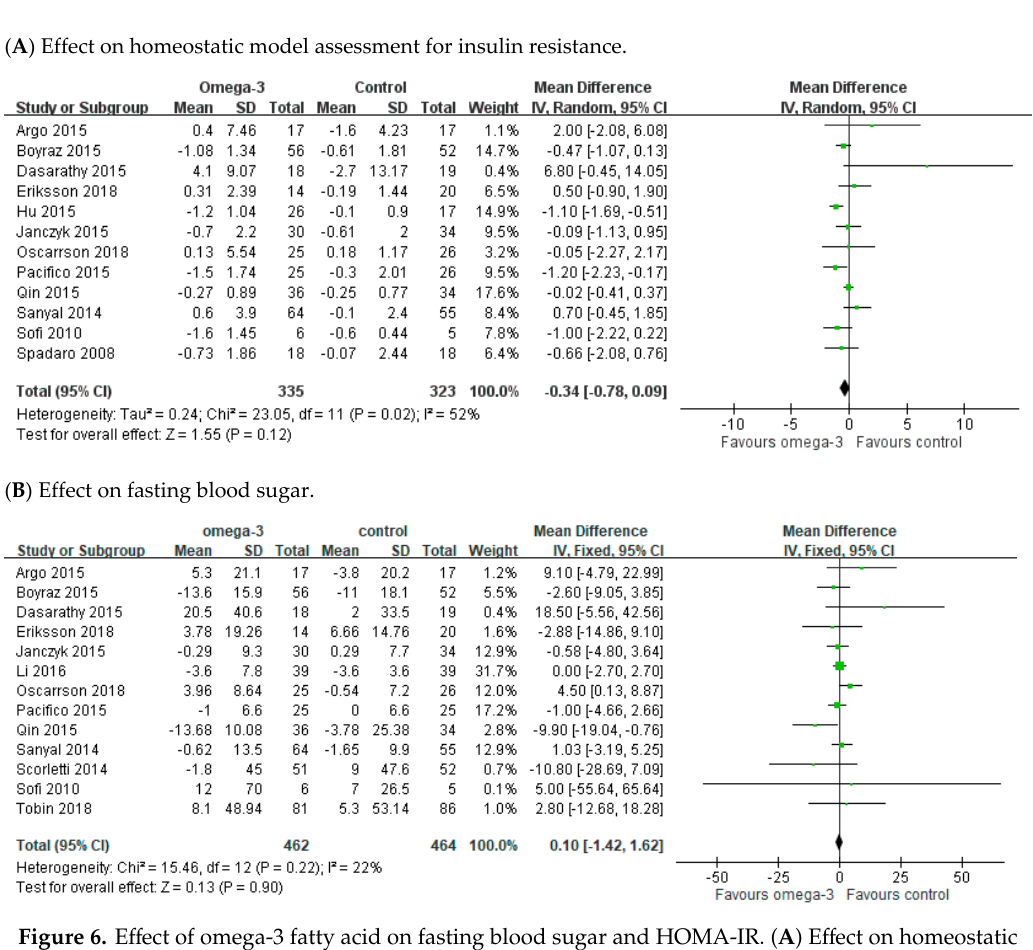
Figure 6. E ff ect of omega-3 fatty acid on fasting blood sugar and HOMA-IR. ( A ) E ff ect on homeostatic model assessment for insulin resistance. ( B ) E ff ect on fasting blood